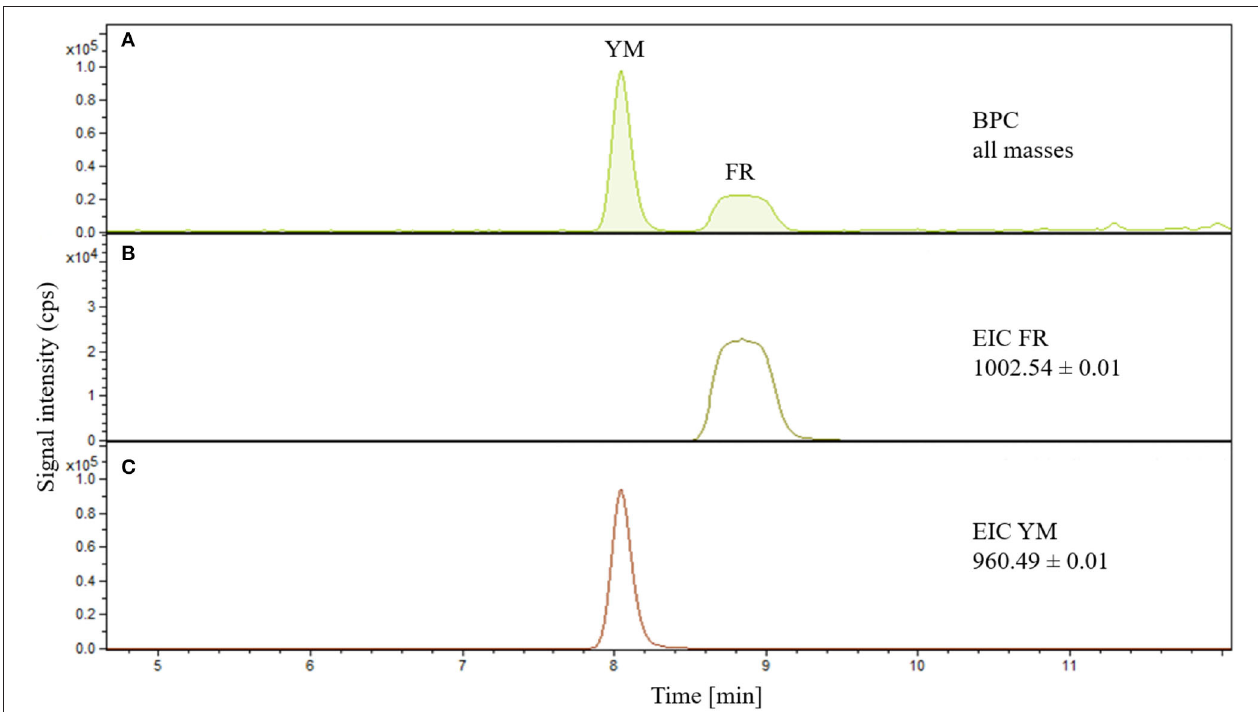
FIGURE 2 | (A) Base peak chromatograms of FR900359 and YM-254890 simultaneously detected. (B) EIC of FR900359, m/z ratio: 1002.54 ± 0.01. (C) EIC of YM-254890, m/z ratio 960.49 ± 0.01.